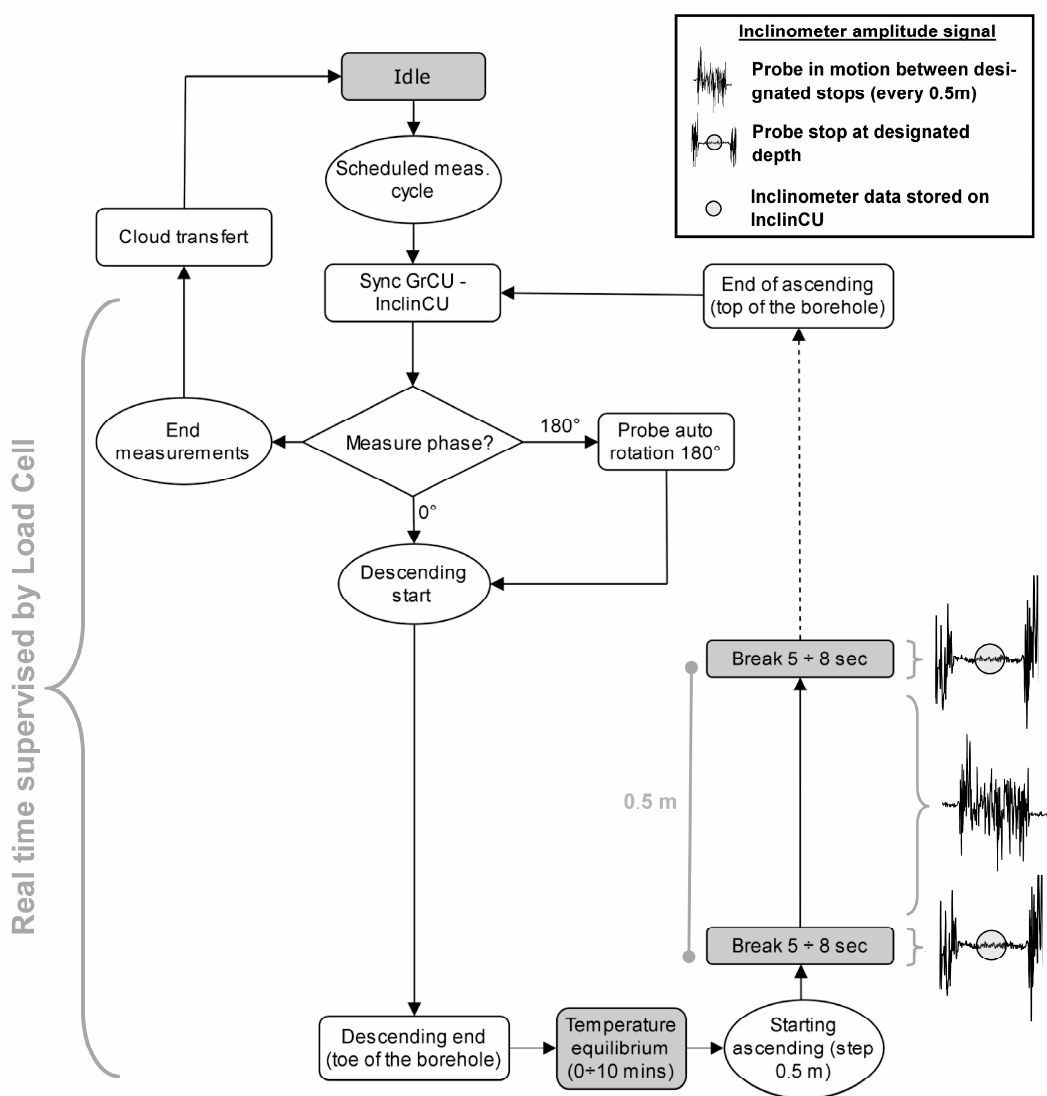
Figure 5. Principle of cycle measurements and signal analysis (automatic probe stop detection). From the start to end cycle, the probe is constantly weighted by the load cell (in the Ground Control Unit (GrCU)) that stops all the activities in case of lightening (obstacles in the tube, excessive deformations, etc.).